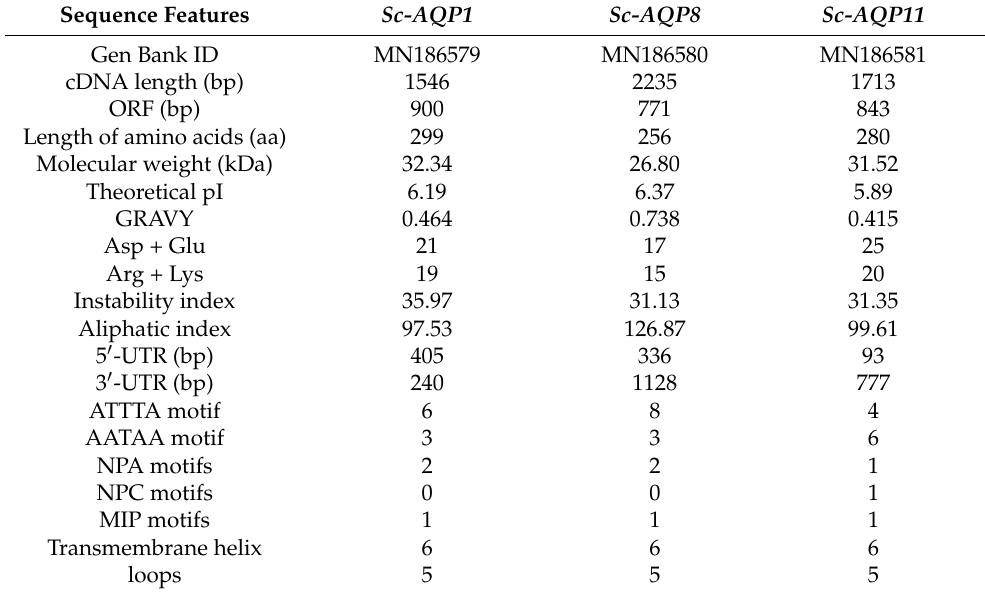
Figure 1. Sc ‐ AQP1 , Sc ‐ AQP8, and Sc ‐ AQP11 3 ’ RACE and 5 ’ RACE amplifications. Figure 1. Sc-AQP1 , Sc-AQP8, and Sc-AQP11 3 (cid:48) RACE and 5 (cid:48) RACE amplifications. Table 2. Summary of sequence features of Sc-AQP1 , Sc-AQP8 , and Sc-AQP11